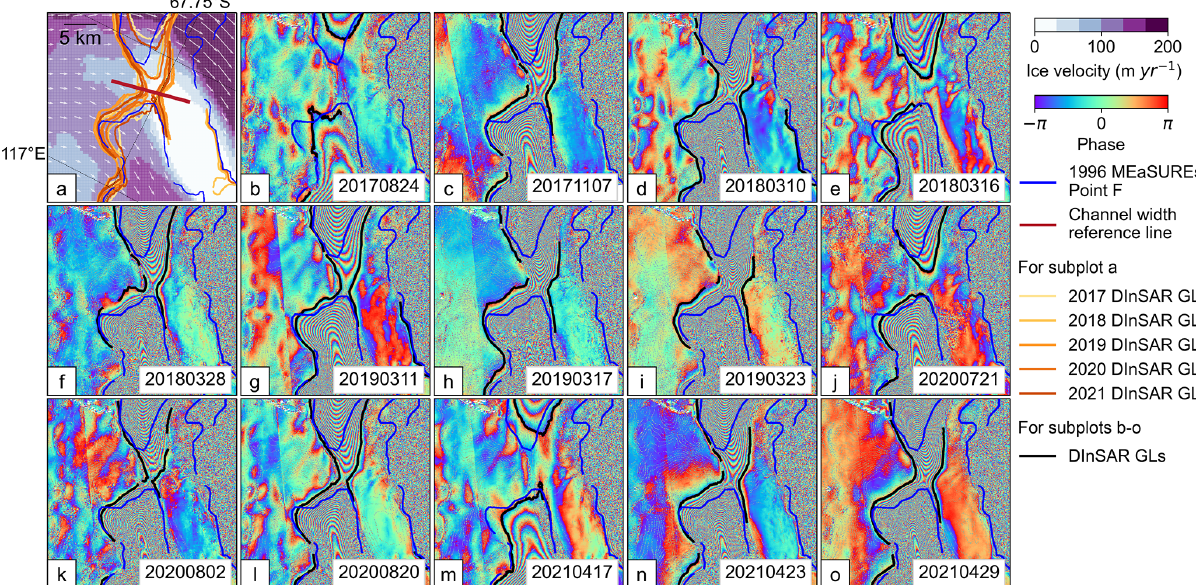
Figure 9. (a) Distribution of different grounding line (GL) products at Totten Glacier Eastern Ice Shelf (TGEIS) ocean channel overlaid with the ice surface velocity magnitudes (Rignot et al., 2017) and ice flow directions (white arrows). The reference line for measuring channel width is shown as the red solid line. The Sentinel-1a/b DInSAR GLs mapped in this study are colour-coded by year. (b–o) GLs (black solid line) delineated from the Sentinel-1a/b DInSAR interferograms between 2017 and 2021 in this study. In all subplots, the 1996 MEaSUREs DInSAR-derived GLs (Rignot et al., 2011, 2016) are shown as blue solid lines.